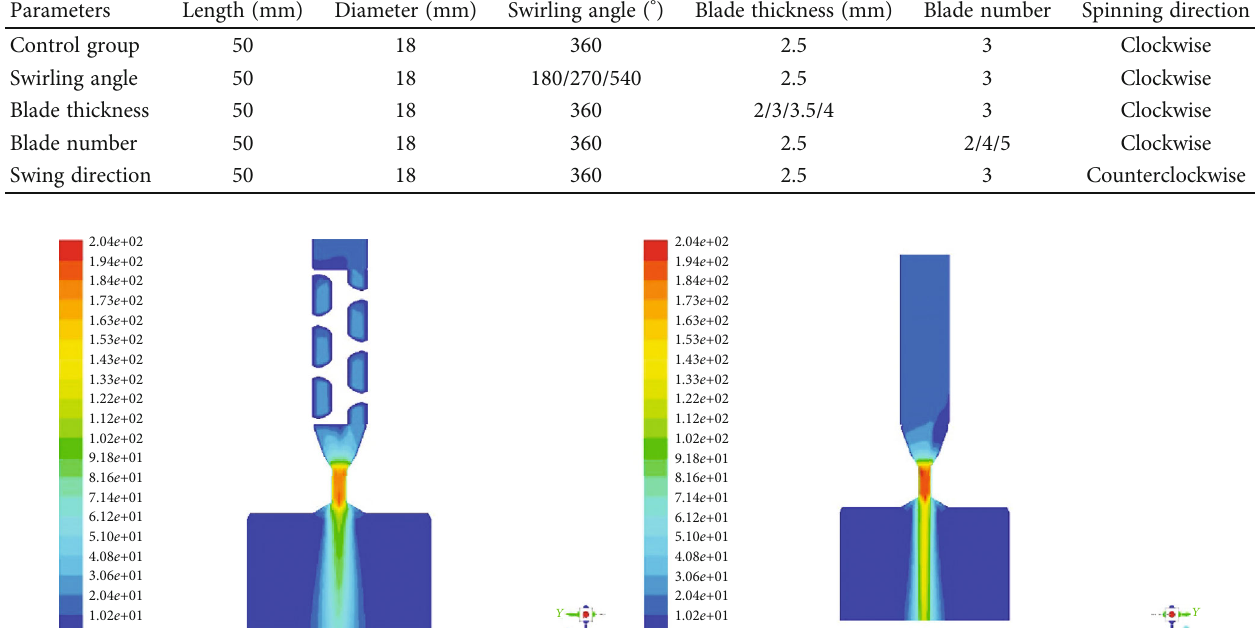
Table 1: Design of structural parameters of the impeller.